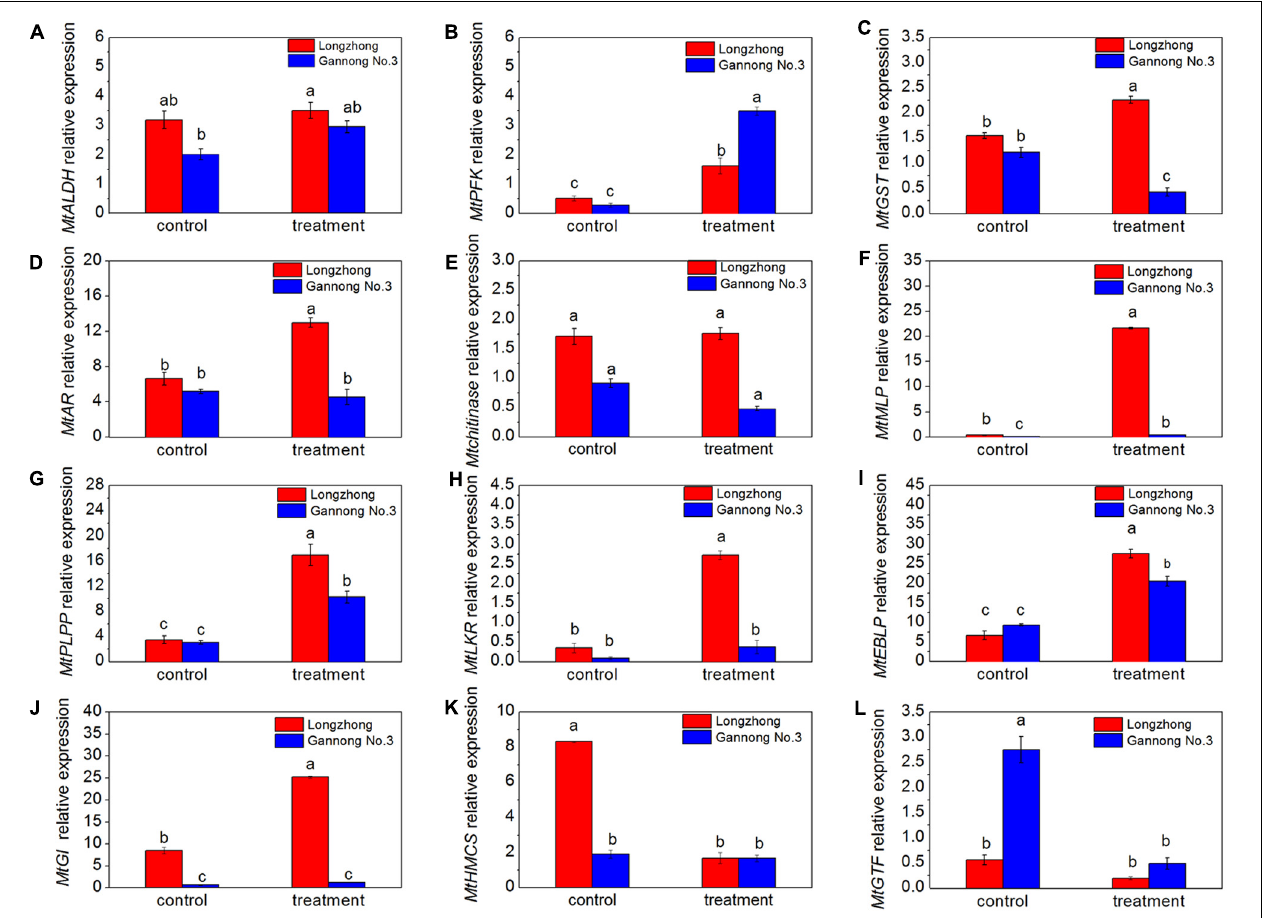
FIGURE 7 | Transcriptional expression of twelve DAPs encoding genes in roots of two alfalfa varieties. (A–L) Changes in expression of MtALDH , MtPFK , MtGST , MtAR , Mtchitinase , MtMLP , MtPLPP , MtLKR , MtEBLP, MtGI , MtHMCS, and MtGTF in roots of two alfalfa varieties after 9 days of PEG-induced osmotic stress. Different letters above columns indicate significant difference ( P ≤ 0.05), and vertical bars above columns indicate ± SE of mean ( n =